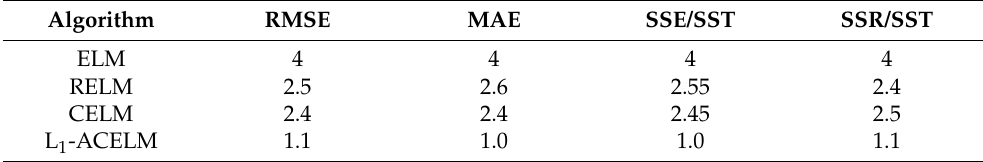
Table 7. Average ranks of benchmark algorithms under noise-free environment.